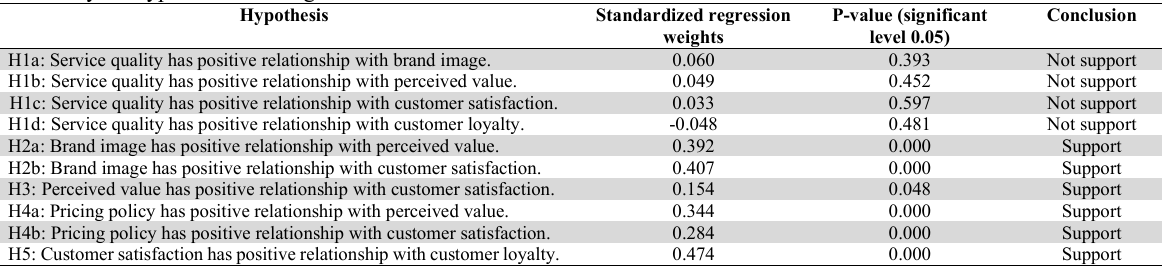
Summary of Hypotheses Testing